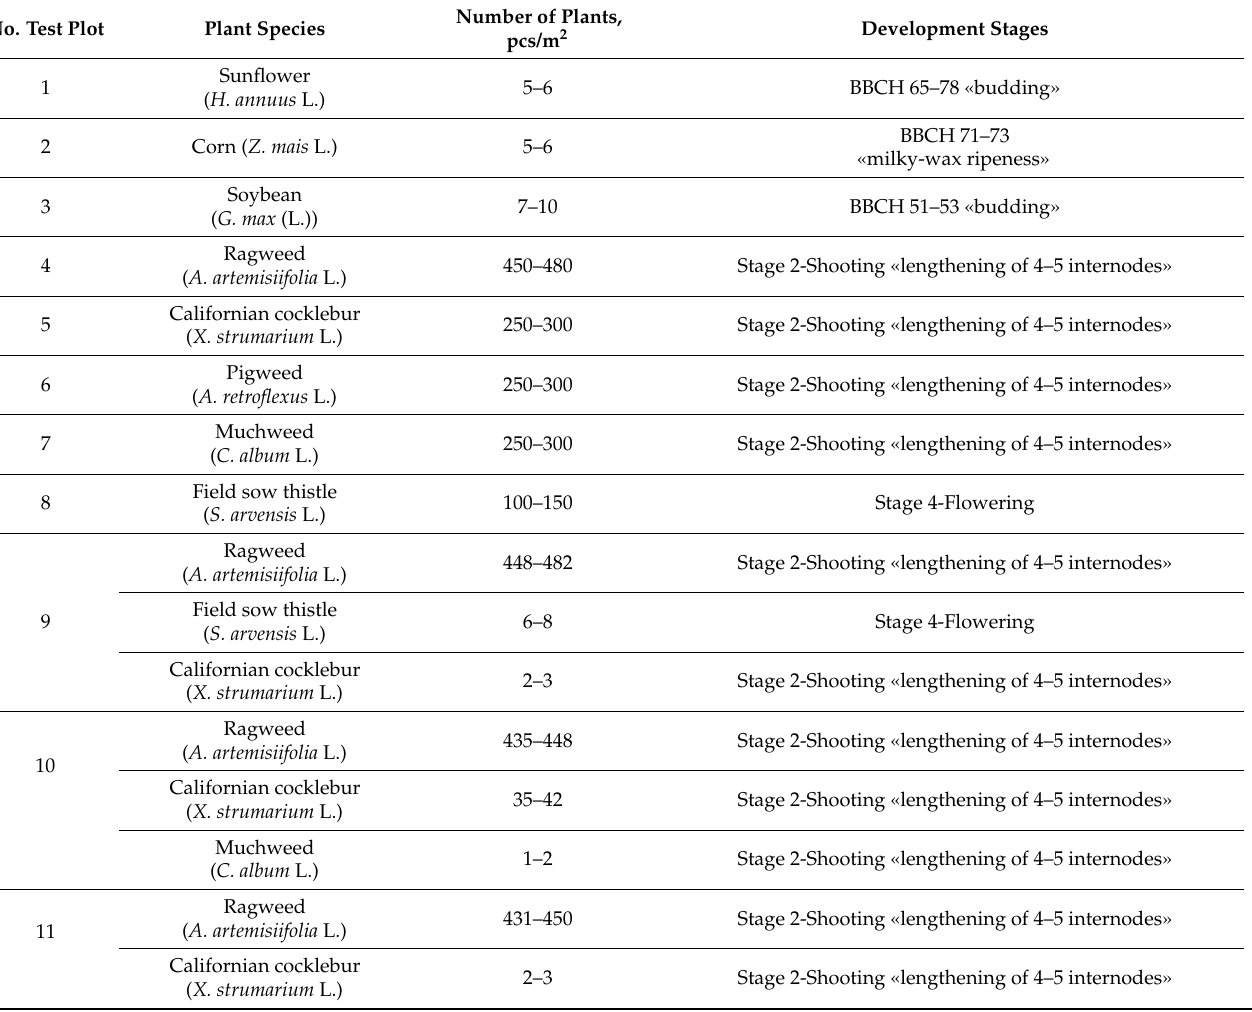
Table 1. Characteristics of the studied plant backgrounds in test